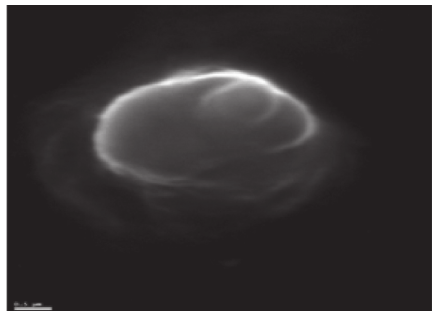
Figure 4: Scanning electron microscopy image of levofloxacin niosomes ( × 20,800).